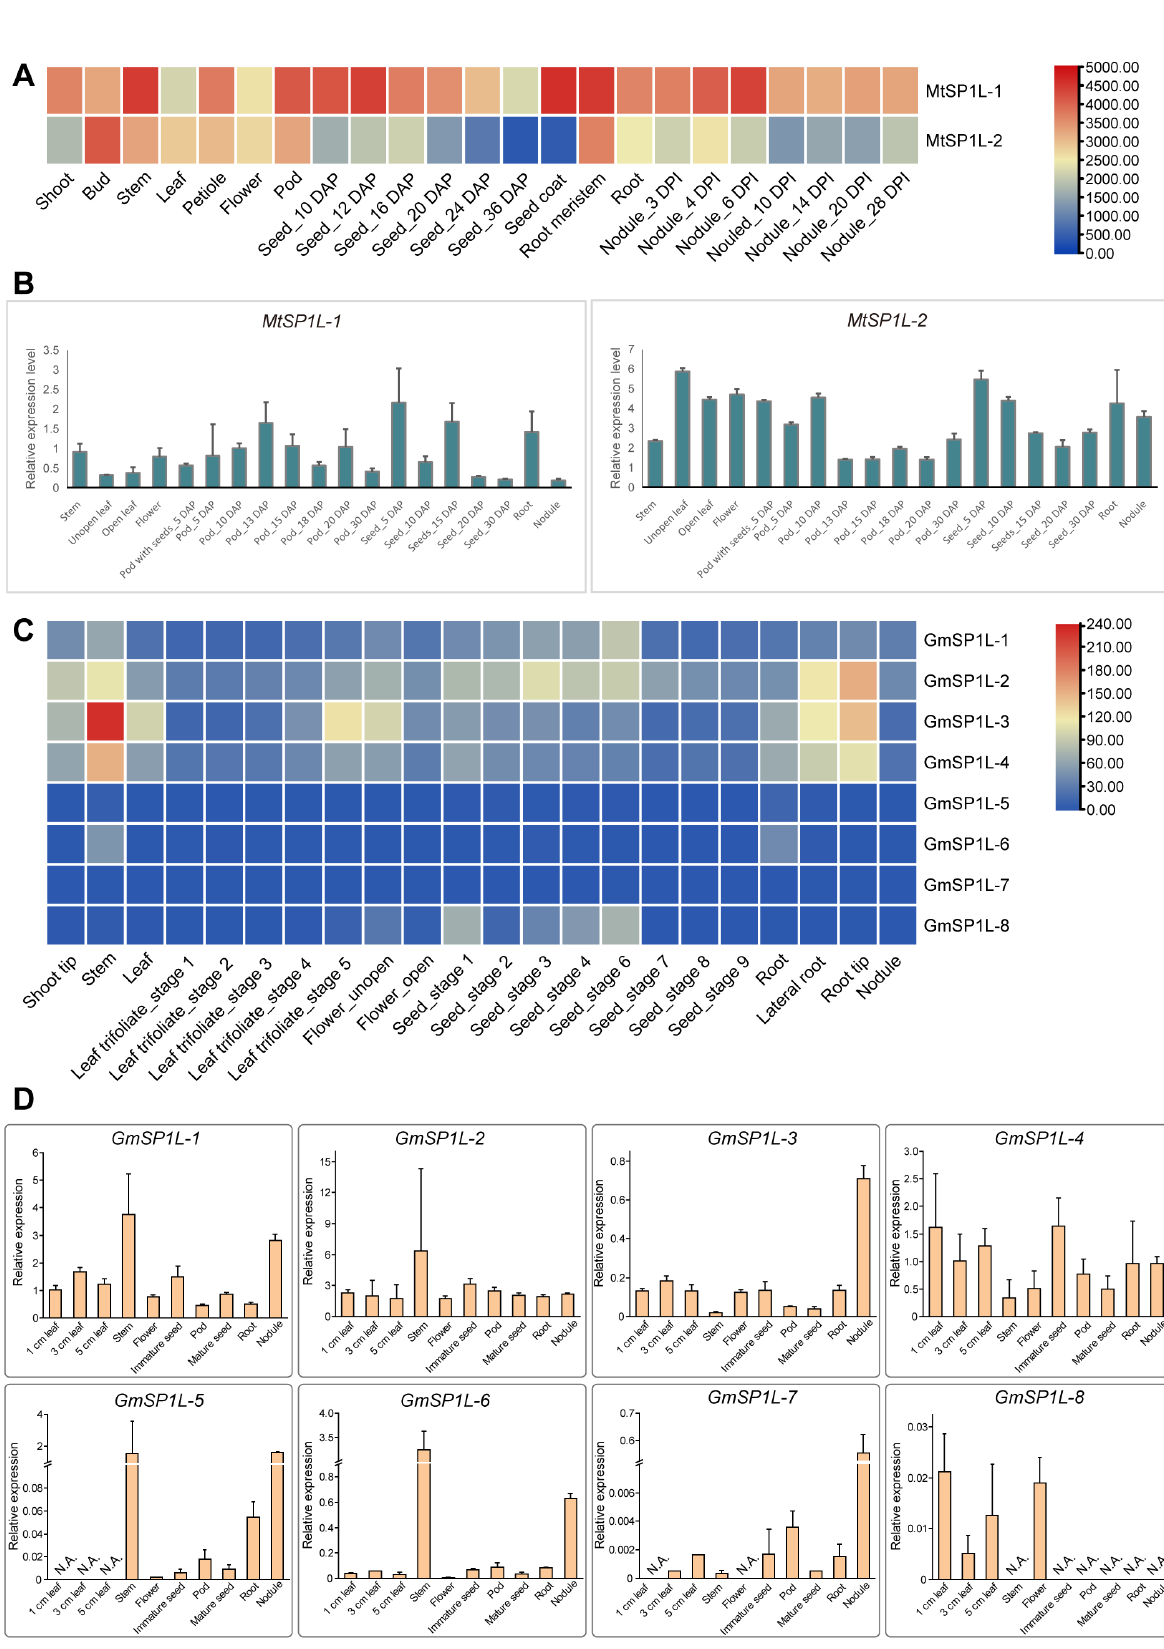
Figure 6. Tissue expression profiles of the SP1L s in Medicago and soybean. ( A ) The expression profiles of two MtSP1L genes in different tissues retrieved from the GeneChip dataset. ( B ) The